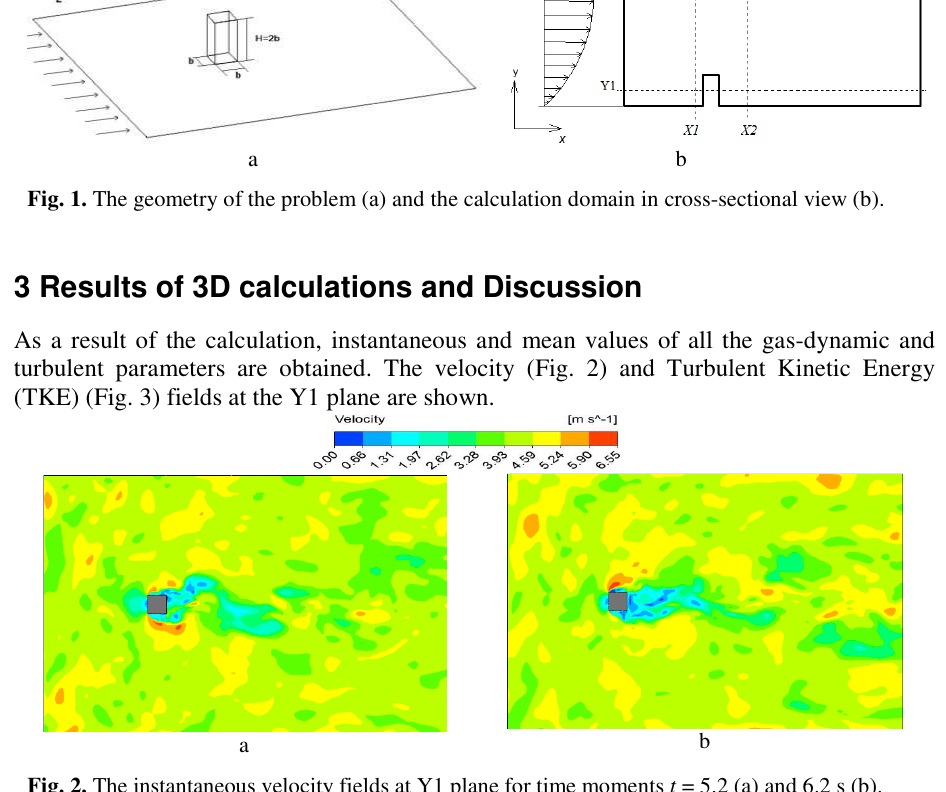
Fig. 2. The instantaneous velocity fields at Y1 plane for time moments t = 5.2 (a) and 6.2 s